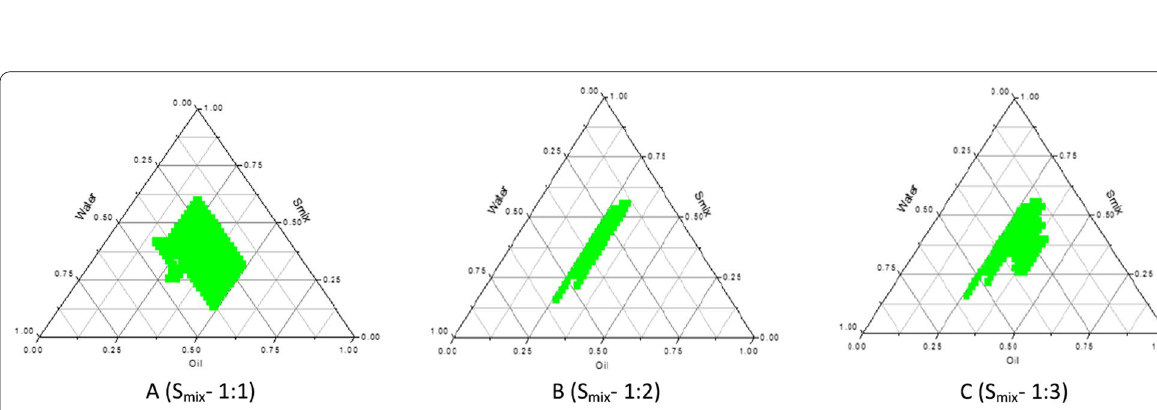
Fig. 5 Phase diagrams to depict the emulsification region for different ratio of S mix